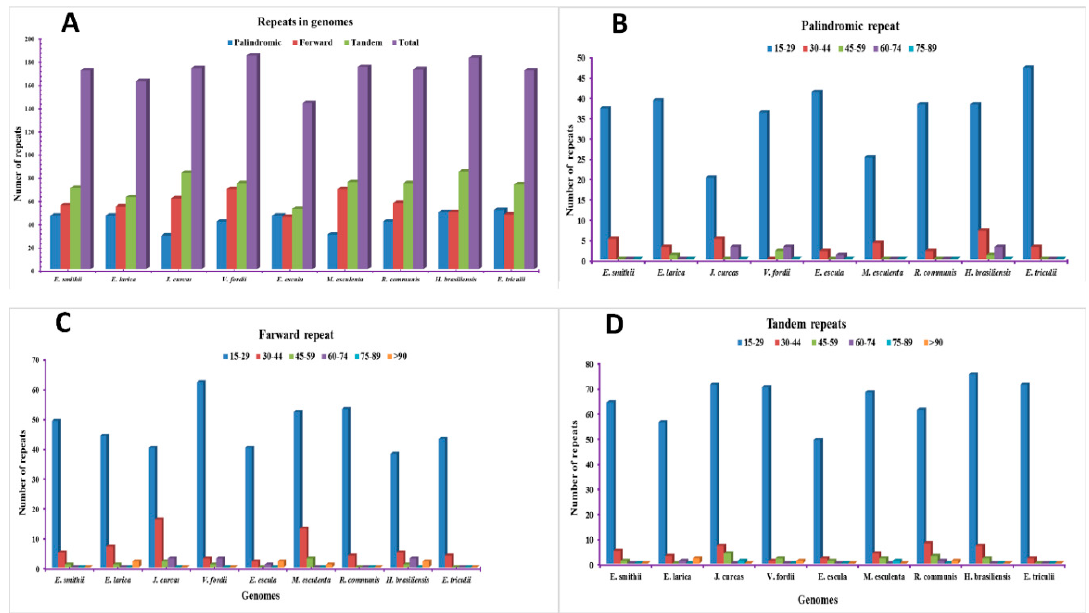
Figure 2. Analysis of repetitive sequences in E. smithii and E. larica. ( A ) Total number of repeats present in the genome. ( B ) Number of palindromic repeats in the genome. ( C ) Number of forward repeats present in the genome. ( D ) Number of tandem repeats present in the genome.